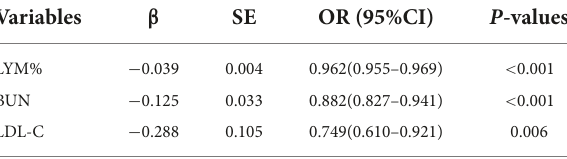
TABLE 4 Results of multivariate logistic regression model.